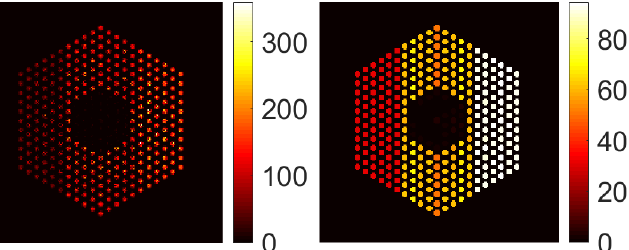
Figure 8. Pin activity estimation using PIDAL- (cid:96) 1 , using the Poisson noise model when the peak value is set to 220. ( Left ): all pin pixels; ( right ): average of pin